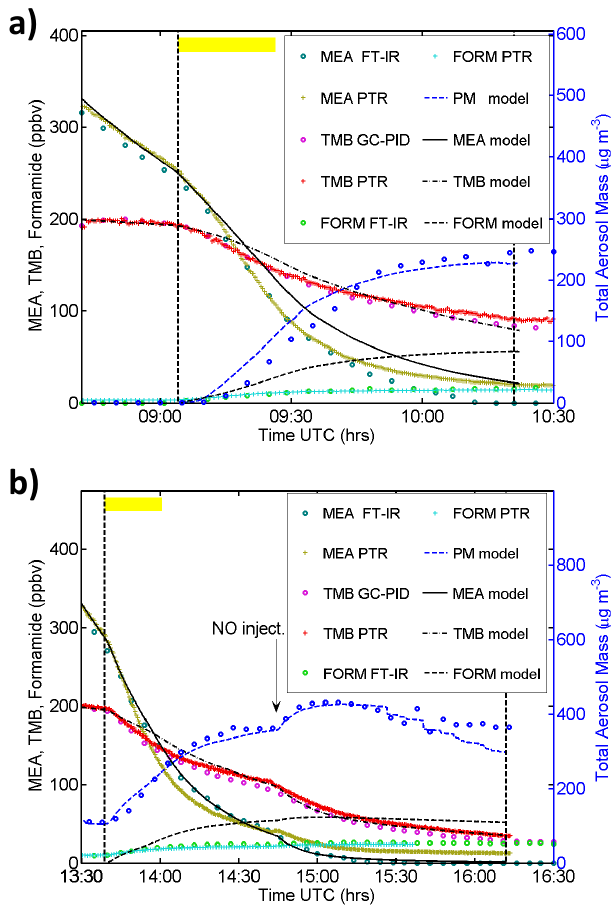
Fig. 3. Measured and modelled time series of MEA, TMB and for- mamide mixing ratios in (a) experiment E1 and (b) experiment E2. MEA measurements (golden crosses) from HT-PTR-MS are partly overlaying the MEA data from FT-IR (dark green circles). Mea- sured (blue circles) and modelled (blue dashed line) total aerosol mass concentrations (PM) are in good agreement. Vertical dashed lines indicate beginning and end of the sunlit experiment. Rate con- stant k 1 was scaled by a factor of 2.6 in the model simulations. Hor- izontal bar (yellow) marks the time period of the experiment used for the relative rate determination using the LSQ model.